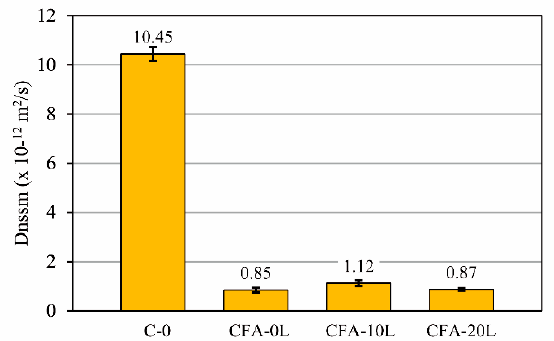
Figure 8. Chloride migration coefficient at the age of three months.